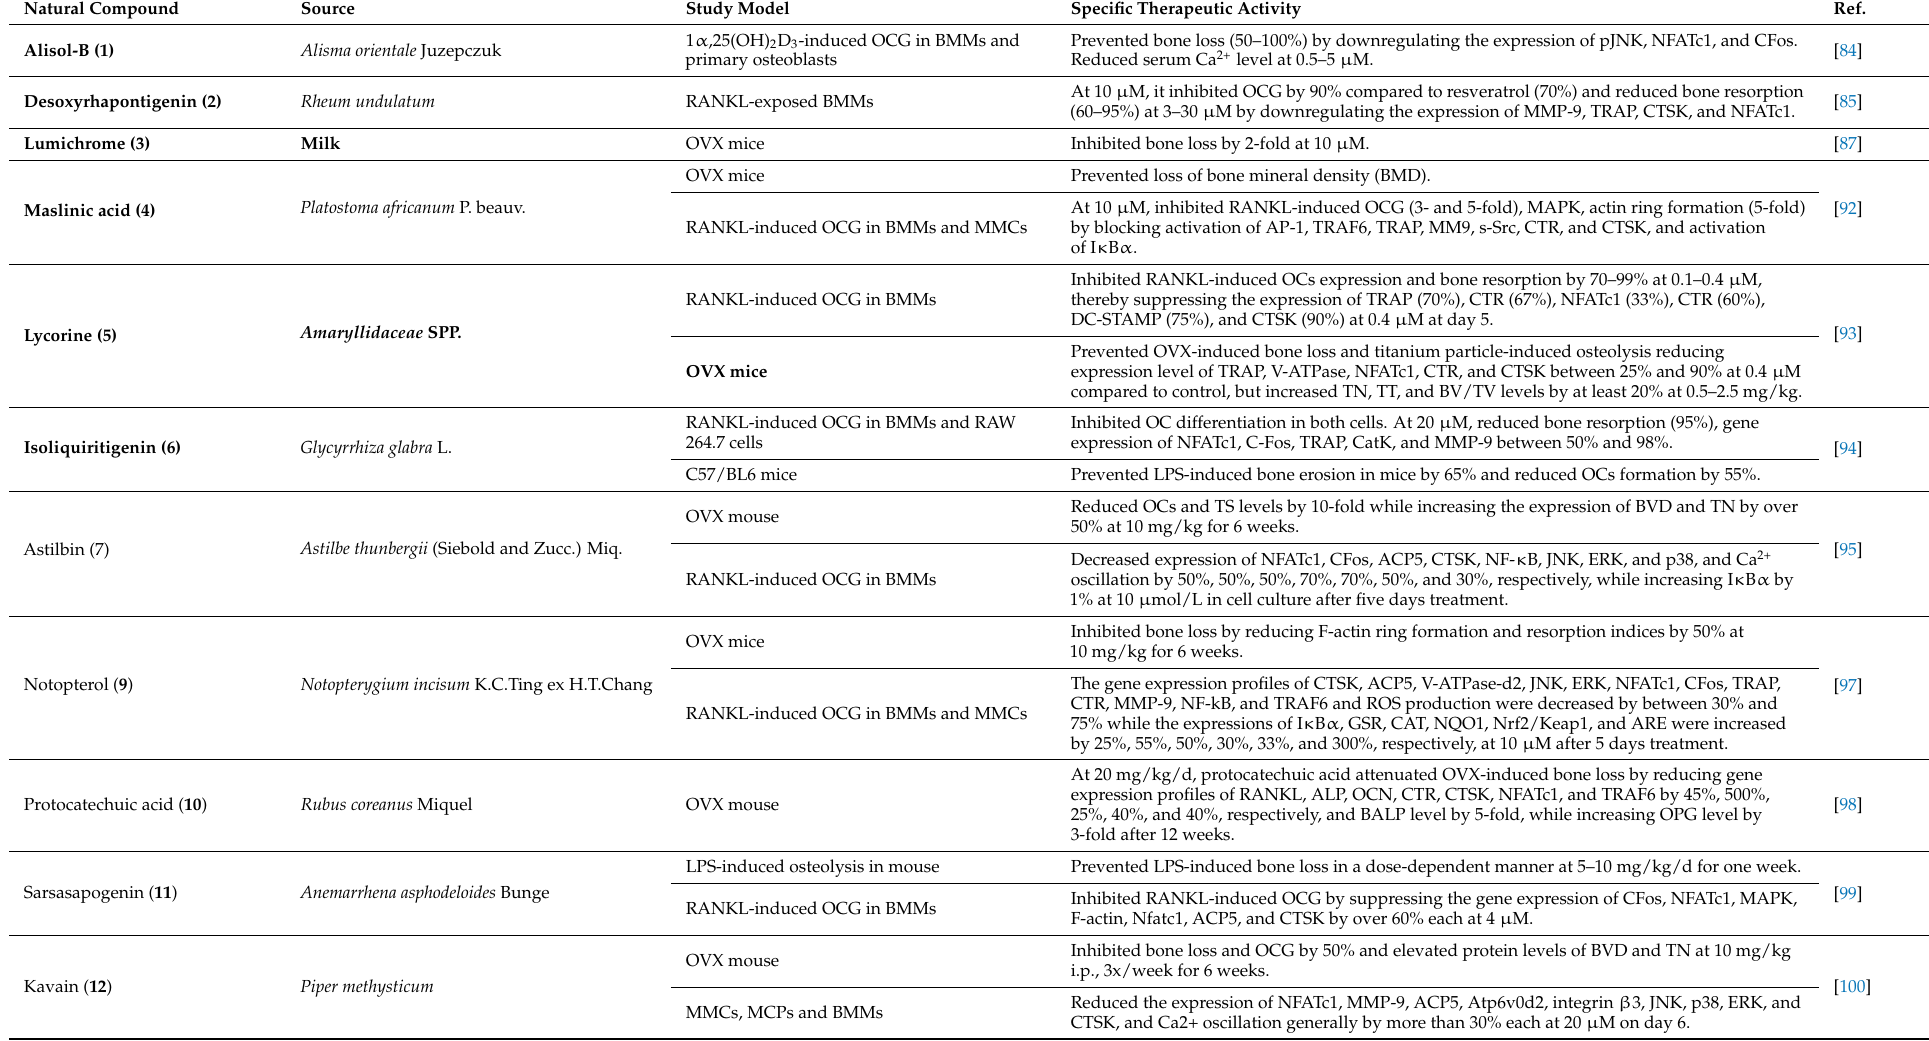
Table 1. Natural compounds with osteoprotective properties via RANKL/M-CSF/OPG and MAPK/JNK/NF-kB signaling